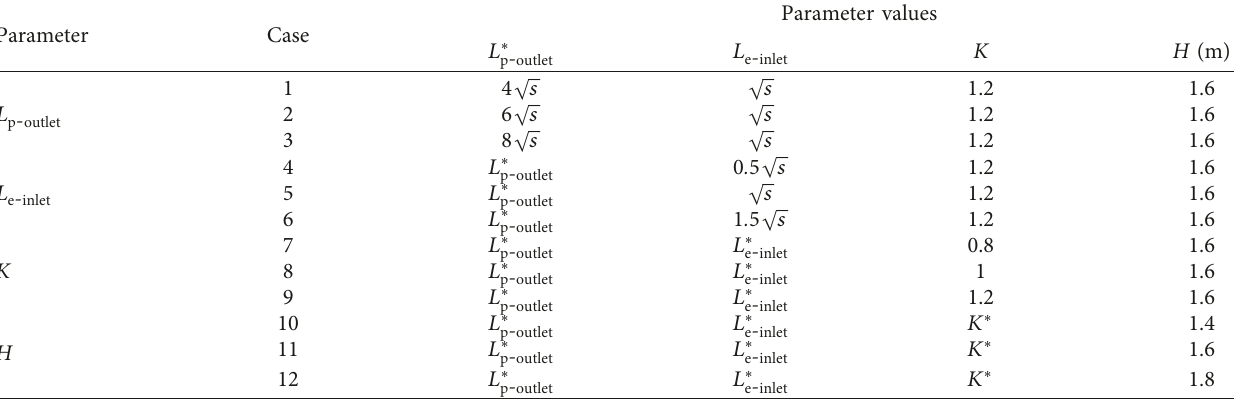
Table 4: Simulation